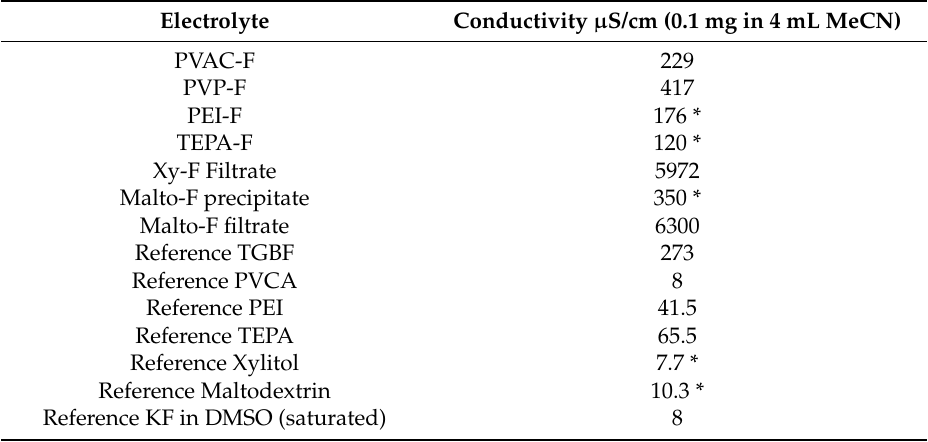
Table 3. Fluoride content and conductivity of the different compounds (for the abbrevations also refer to experimental